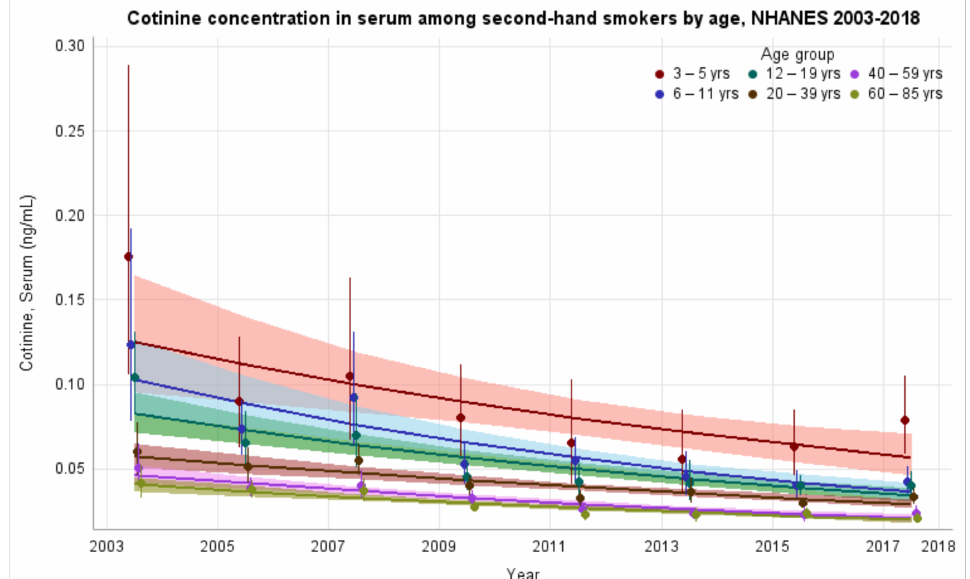
Figure 3. Sample-weighted geometric means (GM) and 95% confidence intervals (CI) of serum cotinine for U.S. nonsmokers aged ≥ 3 years by age group from 2003 to 2018. The data are plotted at the approximate midpoint of each study interval for eight separate NHANES survey cycles. The points represent the GMs and the vertical lines represent 95% CIs of the GMs for each survey cycle. Data points from different age groups within the same NHANES survey have been slightly offset to more easily visualize overlapping 95% CIs. The dark trend lines represent the weighted log-linear regression lines for each age group and the corresponding shaded areas are the 95% CIs of the regression